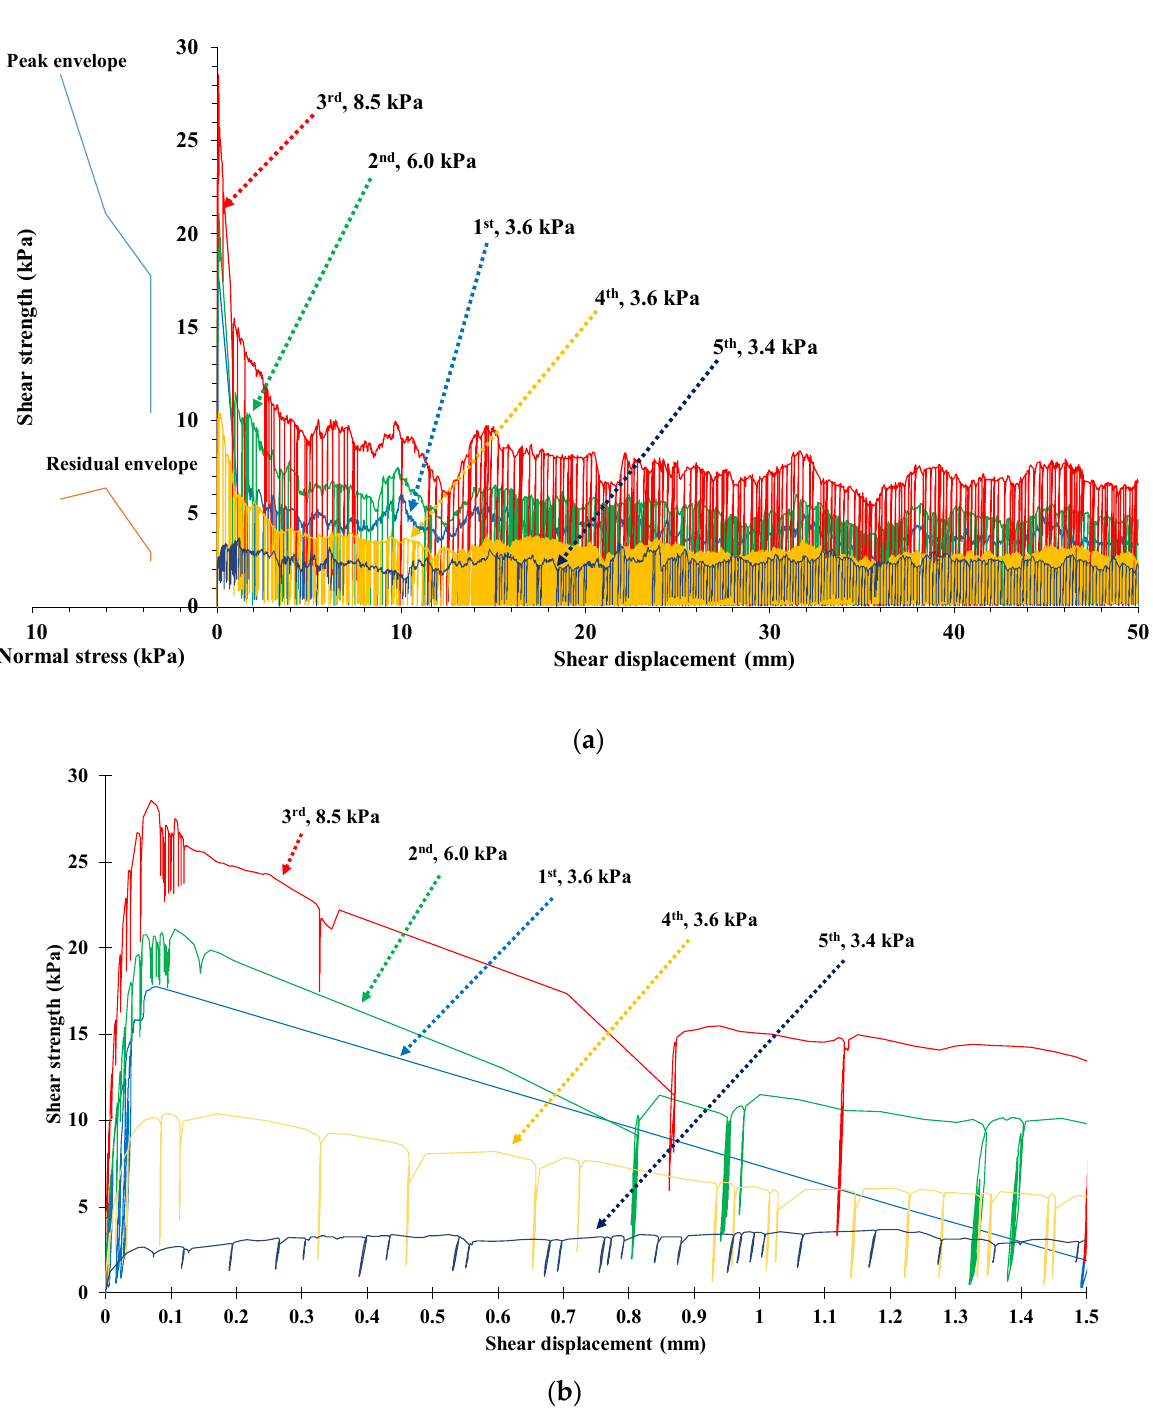
Figure 13. Shear test results for the medium sample (500 mm × 250 mm) as a function of normal stress and shear displace- ment: ( a ) 50 mm displacement, ( b ) 1.5 mm displacement.